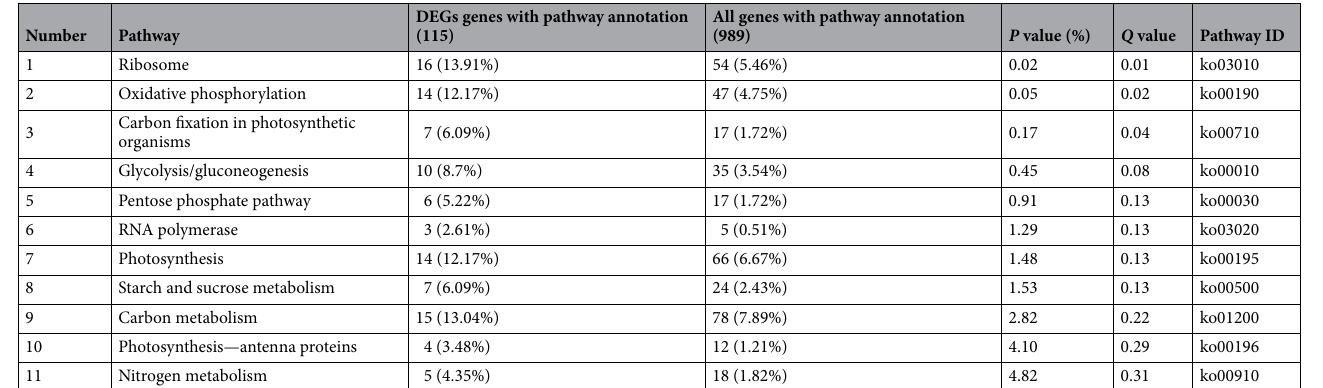
Table 1. Differentially expressed genes enrichment KEGG Pathway. The second column is the pathways; the third column is the number of differentially expressed genes that are noted to a pathway and the percentage of differentially expressed genes to the total number of differentially expressed genes (number of headings); the fourth is the number of genes annotated to a pathway and the percentage of genes to the total number of genes (number of headings); the fifth column is the P value; the sixth column is the Q value after multiple checks; the seventh column is the pathway